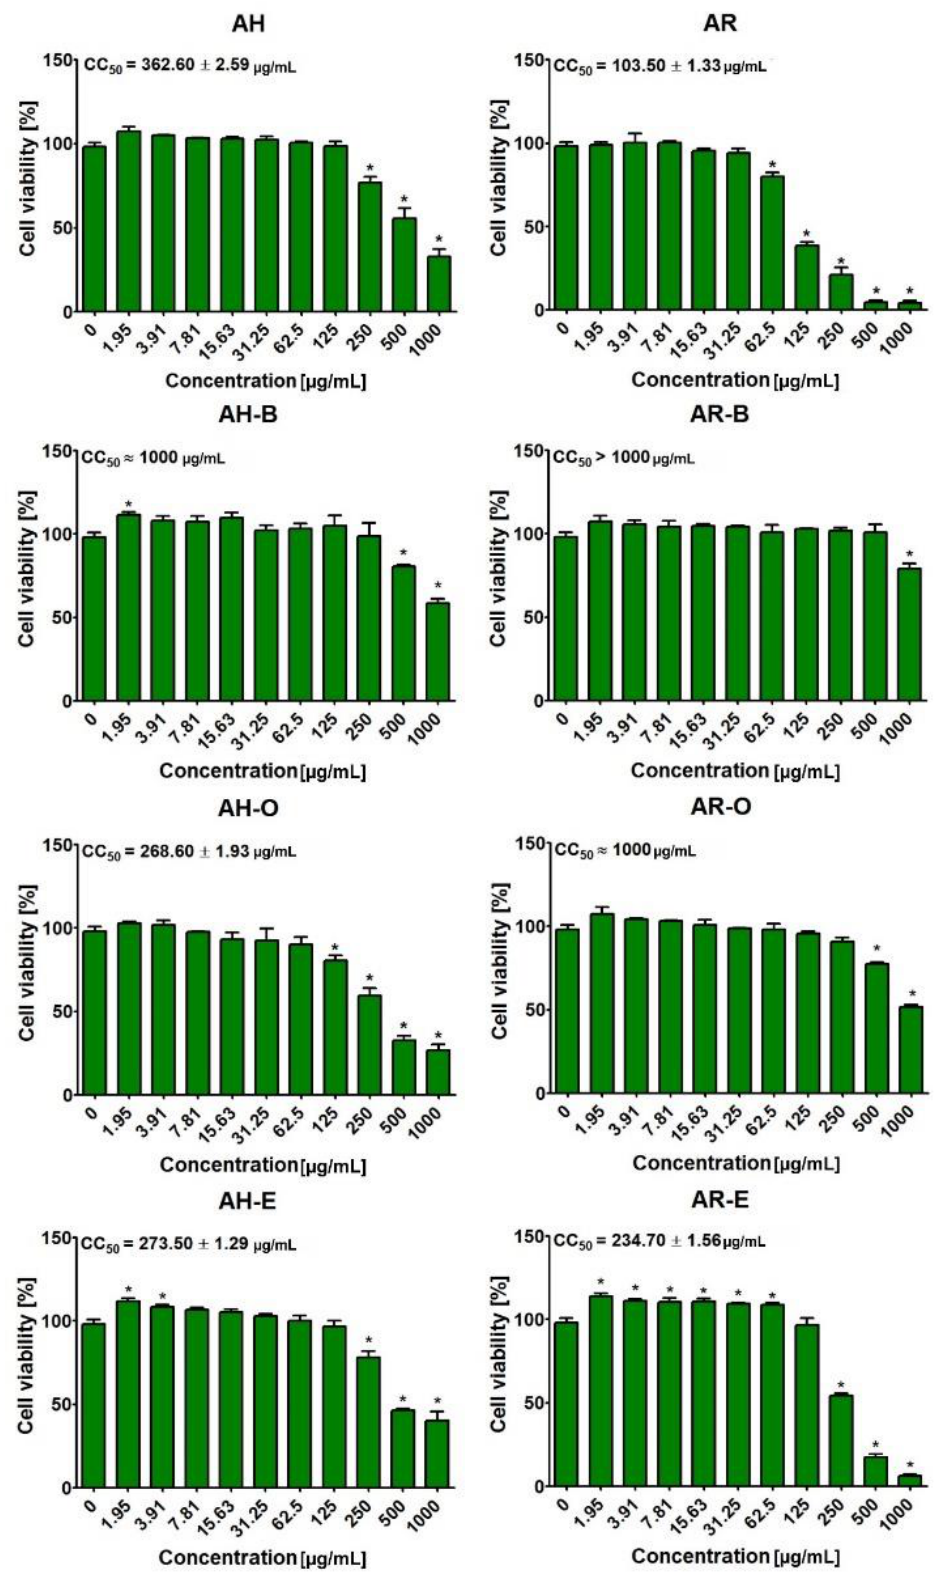
Figure 3. Cell viability after 24-h treatment with AH, AR, AH-B, AR-B, AH-O, AR-O, AH-E, and AR-E compounds. * Significantly different results compared to control cells (incubated without tested compounds —0 μg/mL); unpaired t -test, p < 0.05.